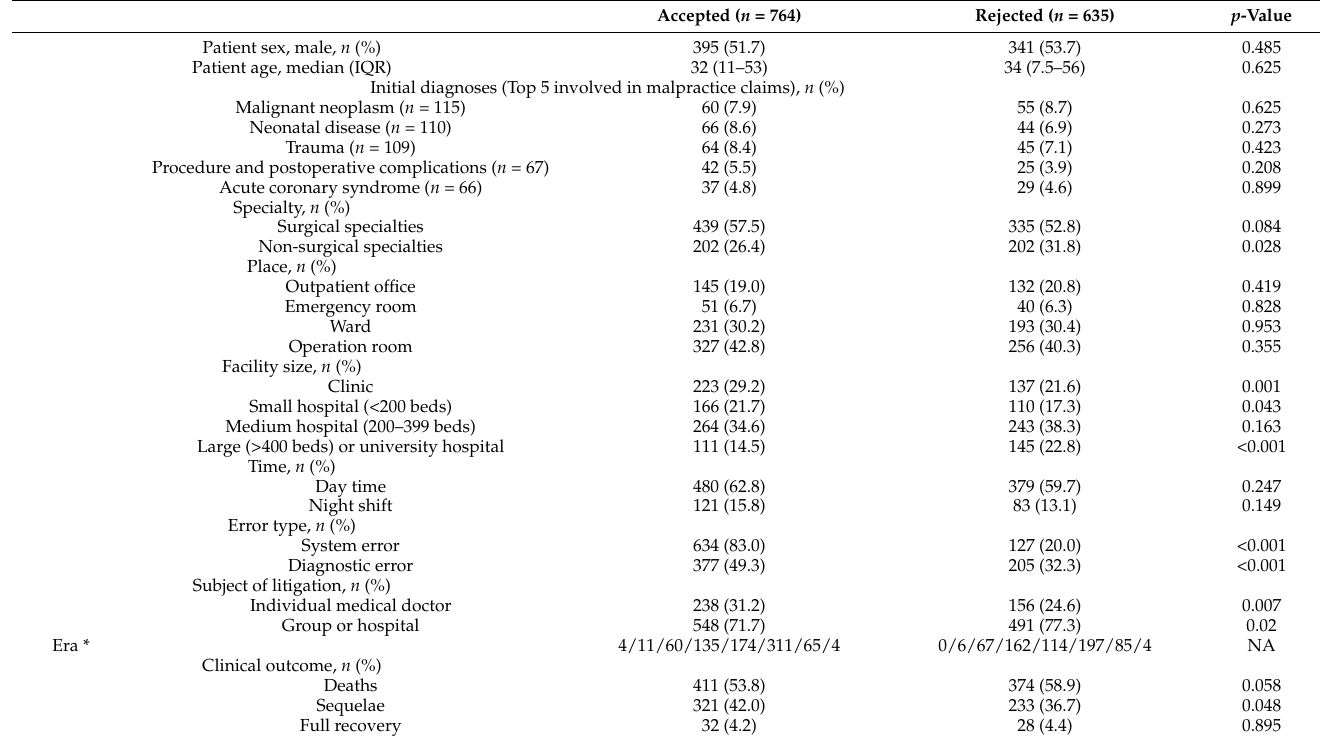
Table 2. Clinical and litigation factors on litigation